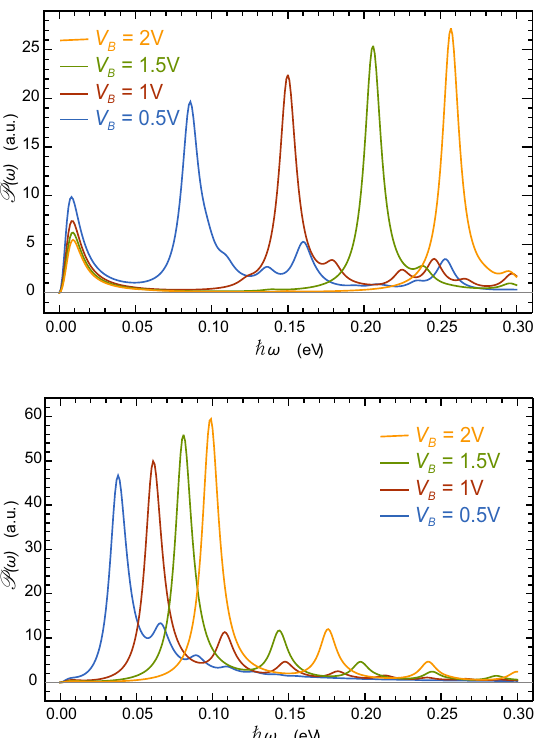
Figure 15. Absorbed power in arbitrary units, P ( ω ) versus photon energy, ¯ h ω , in eV for different bias voltages, V B = 0.5 V, V B = 1 V, V B = 1.5 V, and V B = 2 V. Top figure: case of model 1; bottom figure: case of model